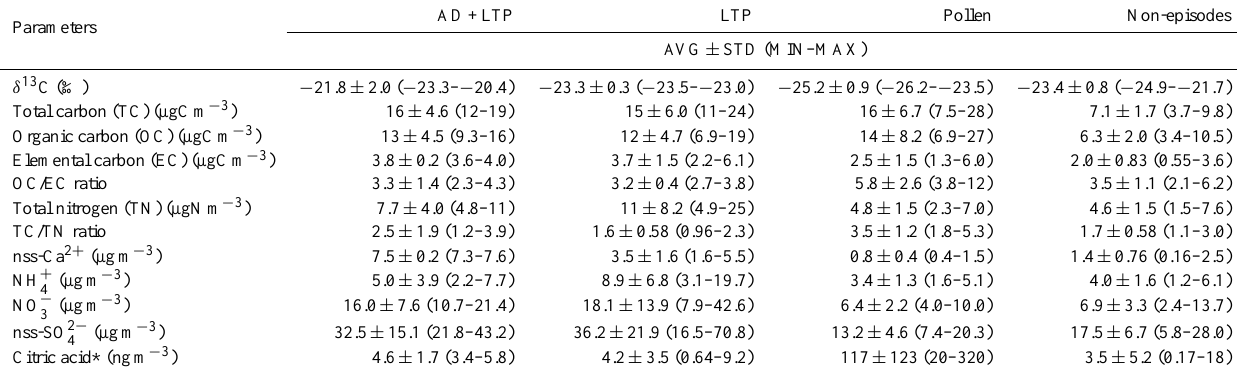
Table 2. Concentrations of chemical compositions and stable carbon isotopic composition ( δ 13 C) in the total suspended particle (TSP) samples collected at the Gosan site during the carbon